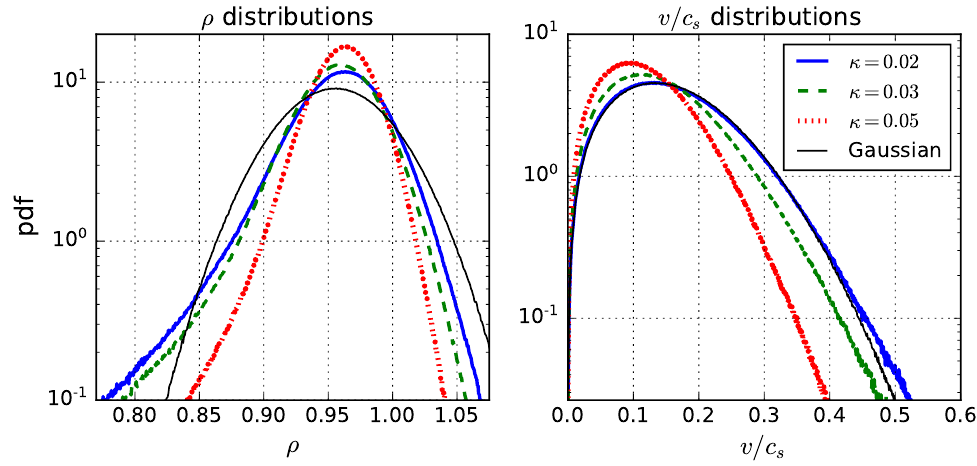
Figure 1 . Probability distribution functions for the inverse-cascade simulations. The pdfs of the energy density (cid:26) (left) and the Mach number v=c s (right) are displayed, where c s = c= on a semi-log scale. All dissipation cases are overlaid for ease of comparison. The density (cid:26) and velocity (cid:12)eld ( v x ; v y ) are high-pass (cid:12)ltered ( k > 10) for a more sensible comparison in this quasi- steady regime (i.e. no large-scale dissipation). The cuto(cid:11) k = 10 is chosen based on the maxima of the spectra in (cid:12)gure 2 occurring at k < 10. For comparison, purely Gaussian distributions are plotted (black, solid, thinner lines) with its average and standard deviation matched to data from the dissipation case (cid:20) = 0 : 02. In the order of increasing energy growth rate, the standard deviations of pdf( (cid:26) ) and pdf( v=c s ) in each case are (0 : 0286 ; 0 : 0395 ; 0 : 0438) and (0 : 122 ; 0 : 147 ; 0 : 167), respectively. In the same order, the rms Mach numbers are (0 : 1386 ; 0 : 1674 ; 0 : 1893). These properties indicate a weakly compressible